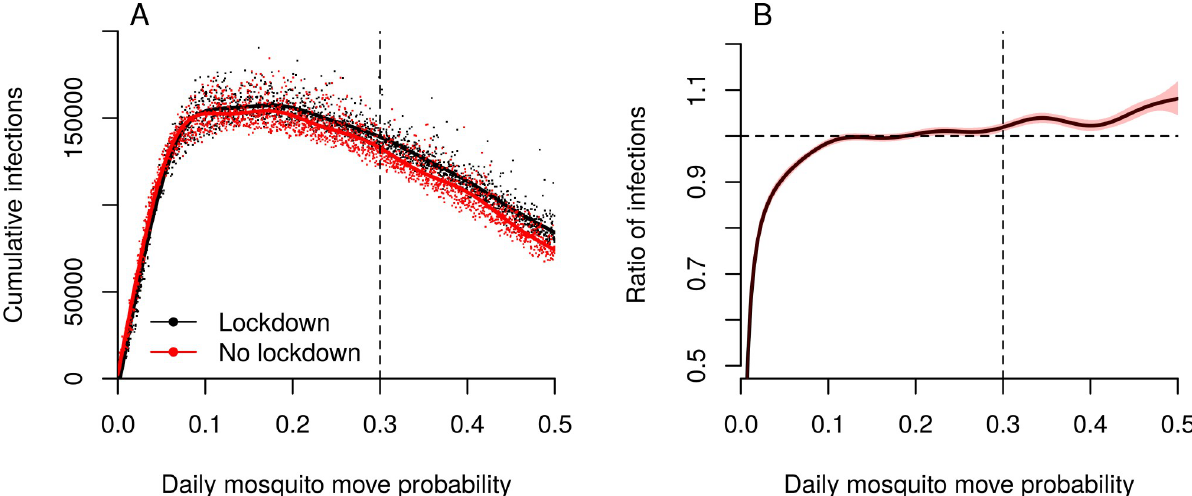
Fig 5. Role of mosquito movement. A. Cumulative infections for different values of daily mosquito movement probability, with and without lockdown. The dashed vertical line indicates the default value (0.3) that was used in all other simulations. B. The ratio of the average number of infections in a lockdown scenario to the number without lockdown. The dashed horizontal line represents when these two situations are the same. If the solid line is above the dashed horizontal line, lockdown resulted in more cumulative infections than when there was no lockdown. The dashed vertical line indicates the default value that was used in all other